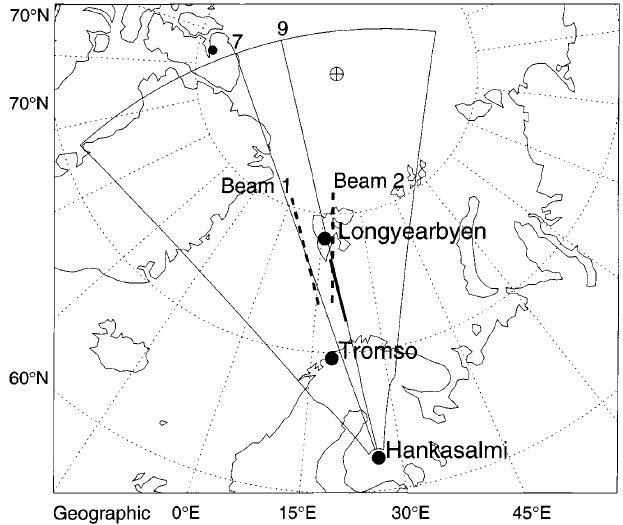
Fig. 1. The geographic location of the field-of-view of the CUTLASS Finland radar, the ESR beam ( solid line ) and both the VHF radar beams ( dashed lines ). Beams 7 and 9 of the CUTLASS radar are highlighted explicitly. The locations of the radars are represented by large solid circles . The smaller solid circle indicates the position of the geomagnetic pole while the position of the geographic pole is represented as a cross within a